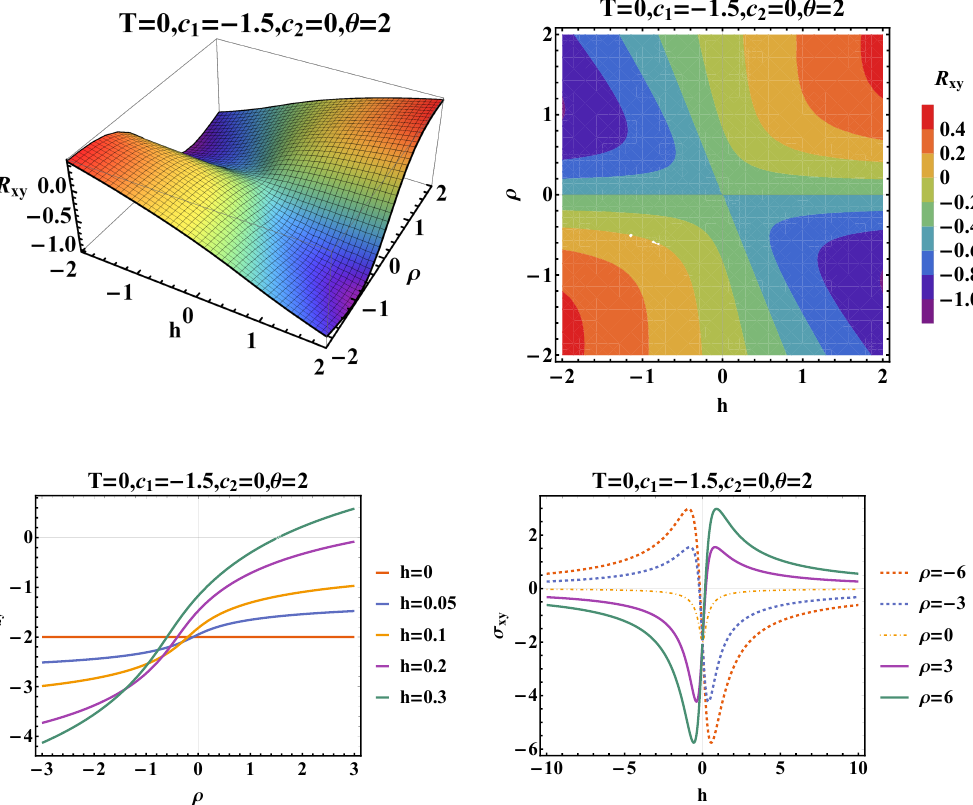
Figure 11 . Upper left: R xy as a function of h and ρ . Upper right: contour plot of R xy . Lower left: σ xy vs ρ with h = 0 , 0 . 05 , 0 . 1 , 0 . 2 , 0 . 3 . Lower right: σ xy vs h with ρ = − 6 , − 3 , 0 , 3 , 6 . We set T = 0 , c 1 = − 1 . 5 , c 2 = 0 and θ = 2